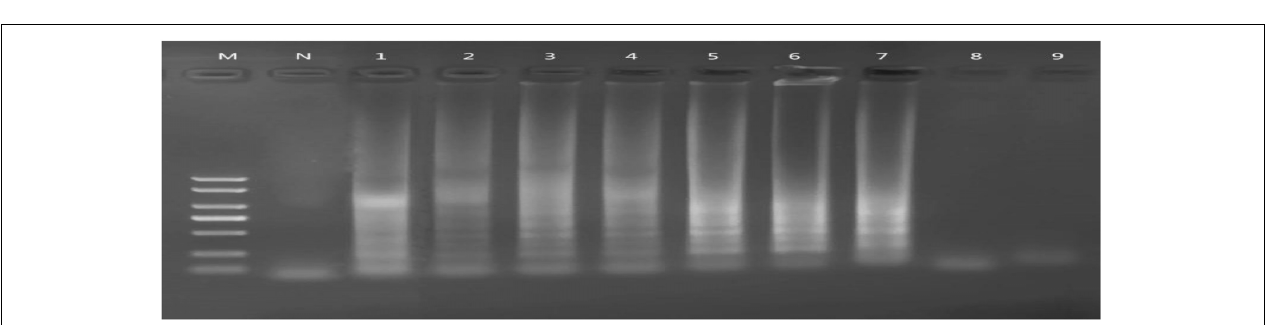
FIGURE 2 | Specificity of peg-344 LAMP. The specificity of the LAMP assay for detecting peg-344 producers by assessing its reactivity with other kinds of standard strains. 1: Klebsiella pneumoniae NTUH-K2044 2-16: as shown in Table 1 .